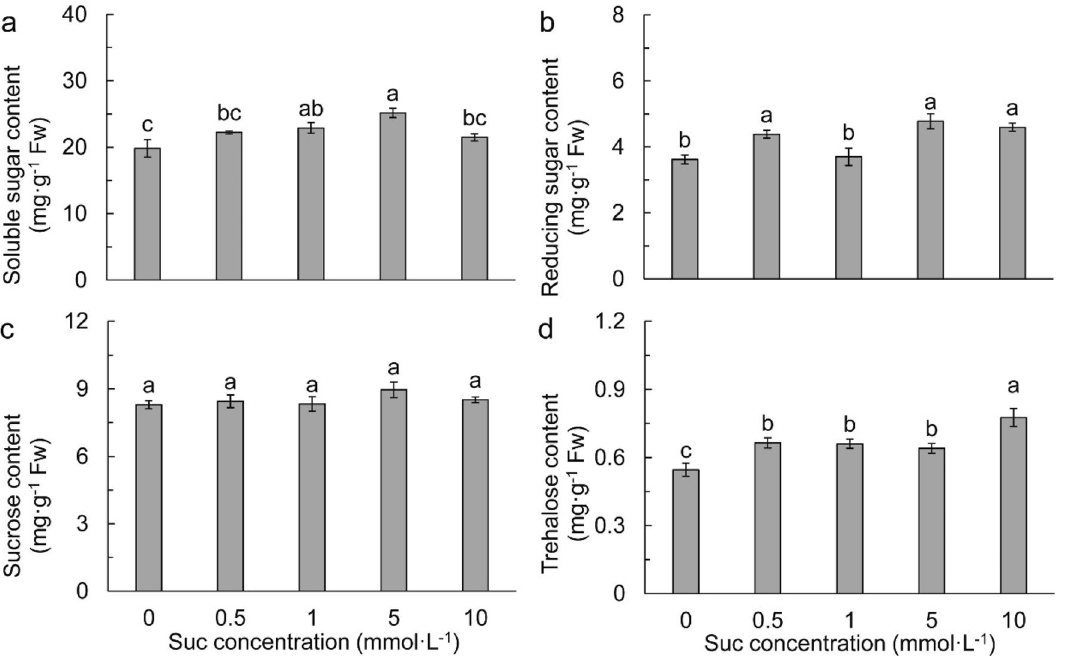
Figure 5. Total soluble sugar ( a ), reducing sugar ( b ), sucrose ( c ), and trehalose ( d ) in different sucrose concentrations. Data refers to means ± SE ( n = 4). Bars with the same letter are no statistically significantly difference at P < 0.05 by Duncan’s new multiple range method.